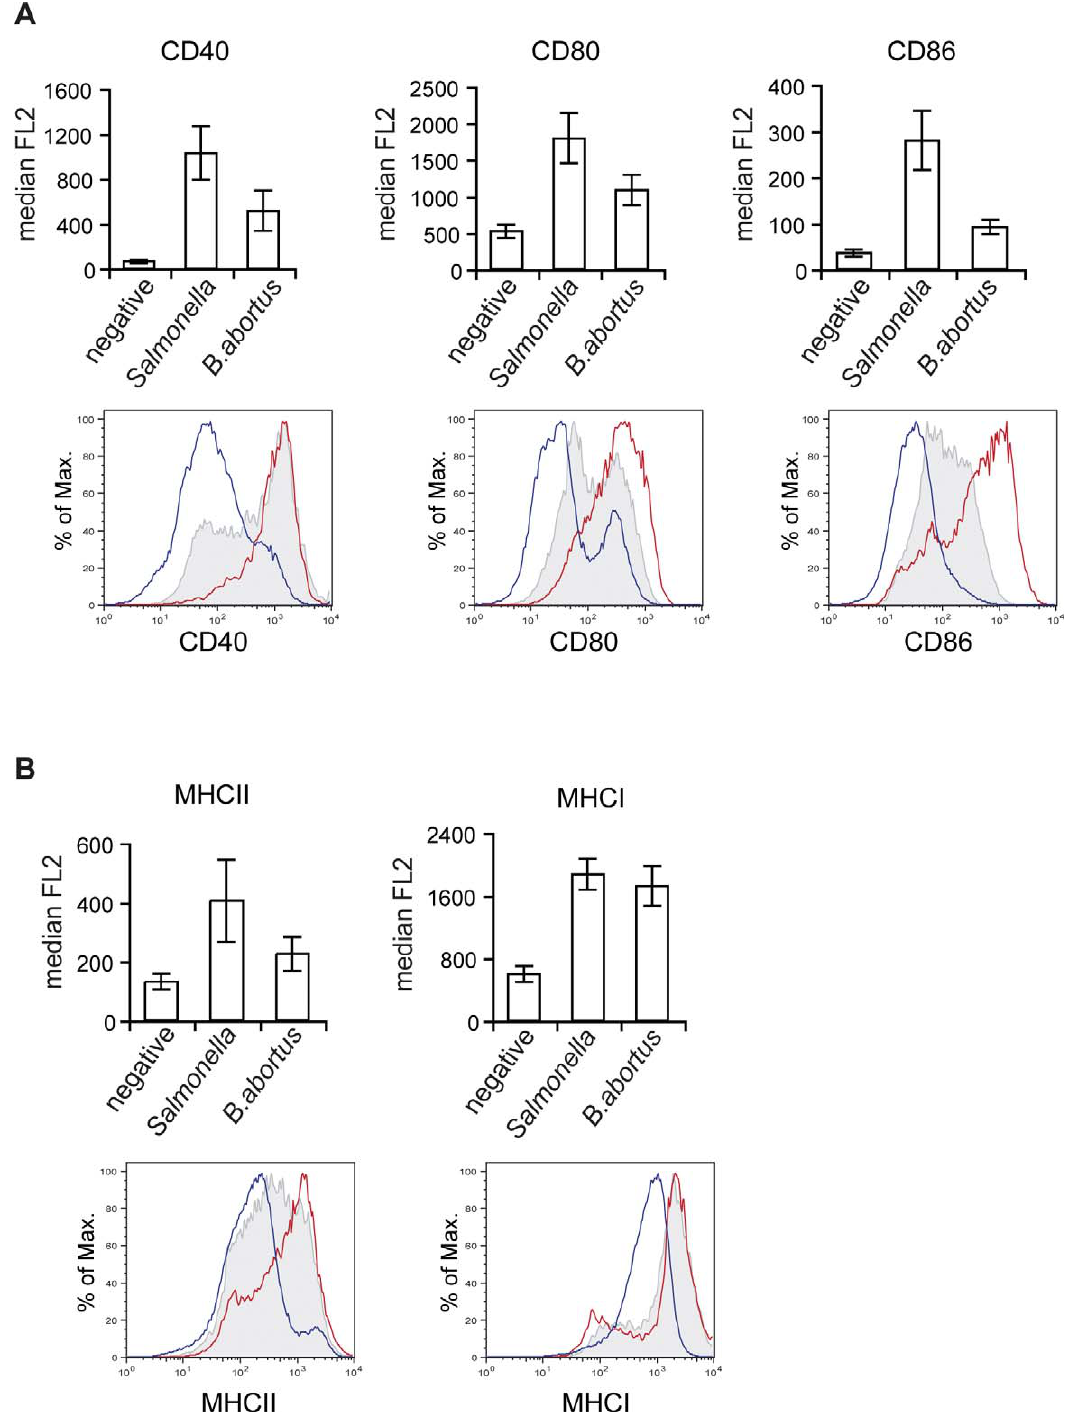
Figure 4. B. abortus -infected DCs Have Reduced Expression of Co-stimulatory Molecules (A and B) DCs were either incubated with media only (blue line) or infected with B. abortus (shaded grey) or S. typhimurium (red line) expressing GFP for 24 h. DCs were labelled with anti-CD11c conjugated with APC and anti-CD40, CD80, CD86, MHC II, and MHCI antibodies conjugated with PE. Representative histograms and values of median of the PE fluorescence (FL2) correspond to CD11c þ cells for the negative and CD11c þ GFP þ cells for the Brucella and Salmonella infected cells. Values of the median fluorescence correspond to four independent experiments.